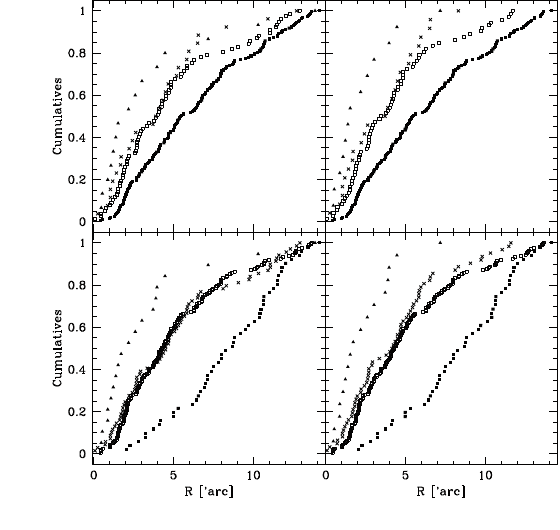
Fig. 24 Mass segregation in NGC 623 for two mass interval sets. The two left panels include all sample stars, while the right ones do not include the 9 bright stars of the cluster corona. For the two top figures M < 5 M (cid:2) (filled squares), M ∈ [ 5 , 10 [ M (cid:2) (open squares), M ∈ [ 10 , 20 [ M (cid:2) (crosses) and M ≥ 20 M (cid:2) (triangles). For the two bottom figures, M < 2 . 5 M (cid:2) (filled squares), M ∈ [ 2 . 5 , 6 . 3 [ M (cid:2) (open squares), M ∈ [ 6 . 3 , 15 . 8 [ M (cid:2) (crosses) and M ≥ 15 . 8 M (cid:2) (triangles). Image reproduced